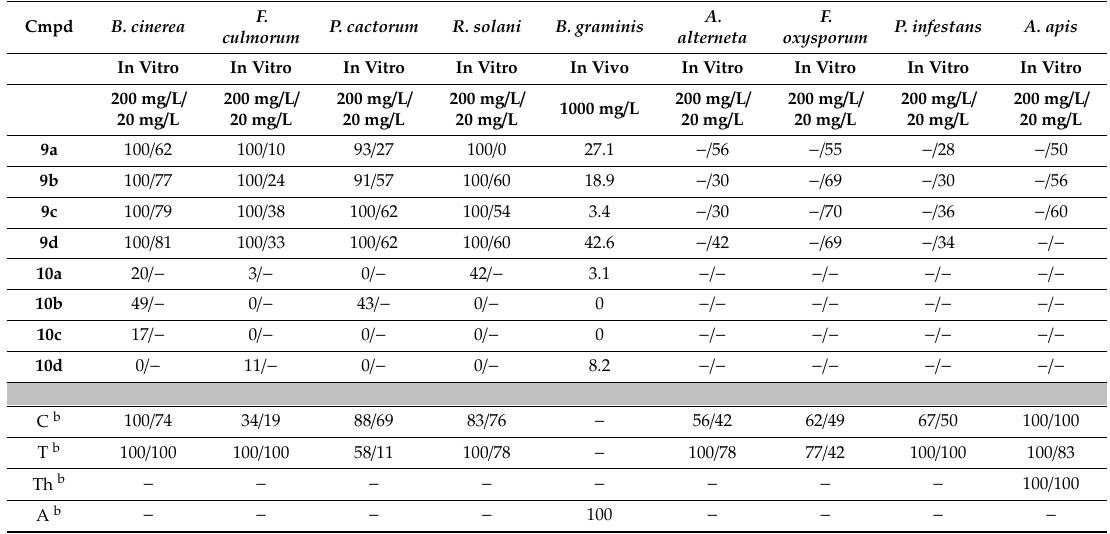
Table 2. Fungistatic activities a of selenocarbamates 9 , 10 at 200 mg / L and 20 mg / L.